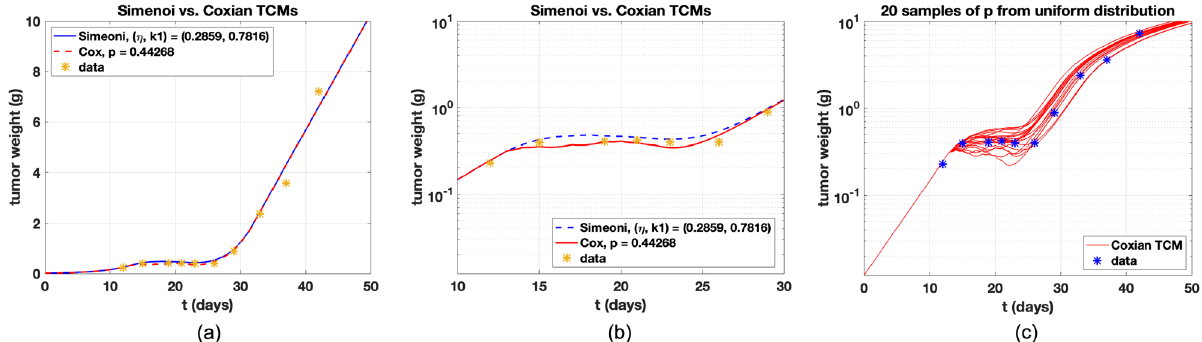
Figure 3. Simeoni and Coxian TCMs are compared. The number of the damaged cells is n = 4 and